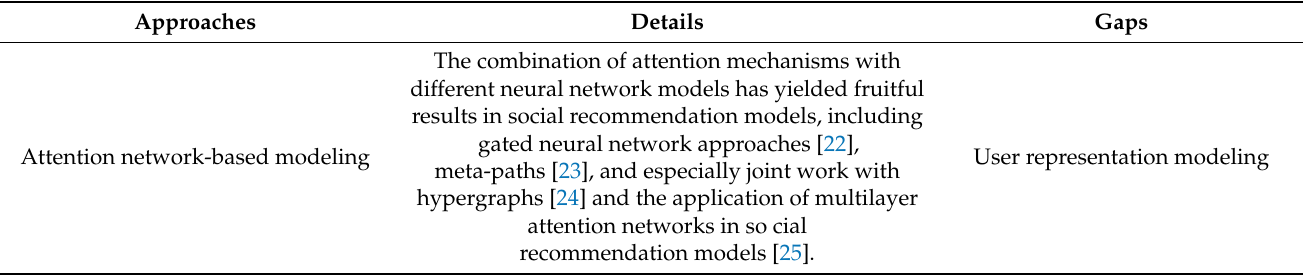
Table 1. Comparison between HGATH and other related works. Approaches Details Gaps The combination of attention mechanisms